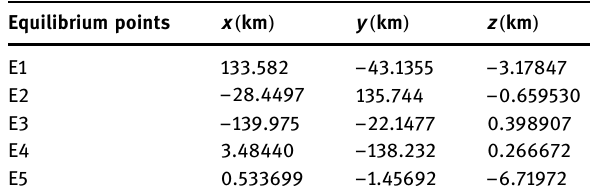
Table 1: Positions of the equilibrium points around Minerva Equilibrium points